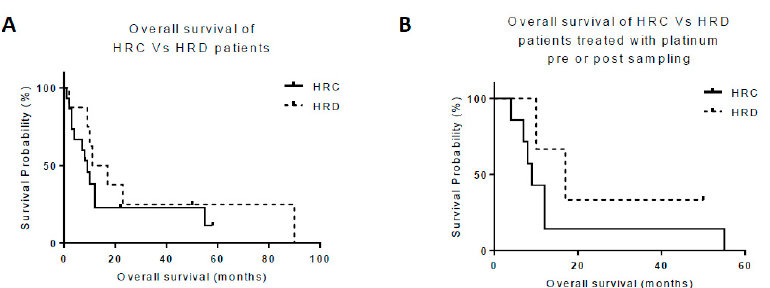
Figure 4. Patient survival. Kaplan–Meier survival curves for overall survival (OS) in HRR-competent (HRC) versus HRR-deficient (HRD) cancers. ( A ) Median OS in patients with HRC cultures was 8 months ( n = 12) in comparison to 11 months in all of the patients with HRD cultures ( n = 8). ( B ) In patients treated with platinum-based chemotherapy, the median OS in patients with